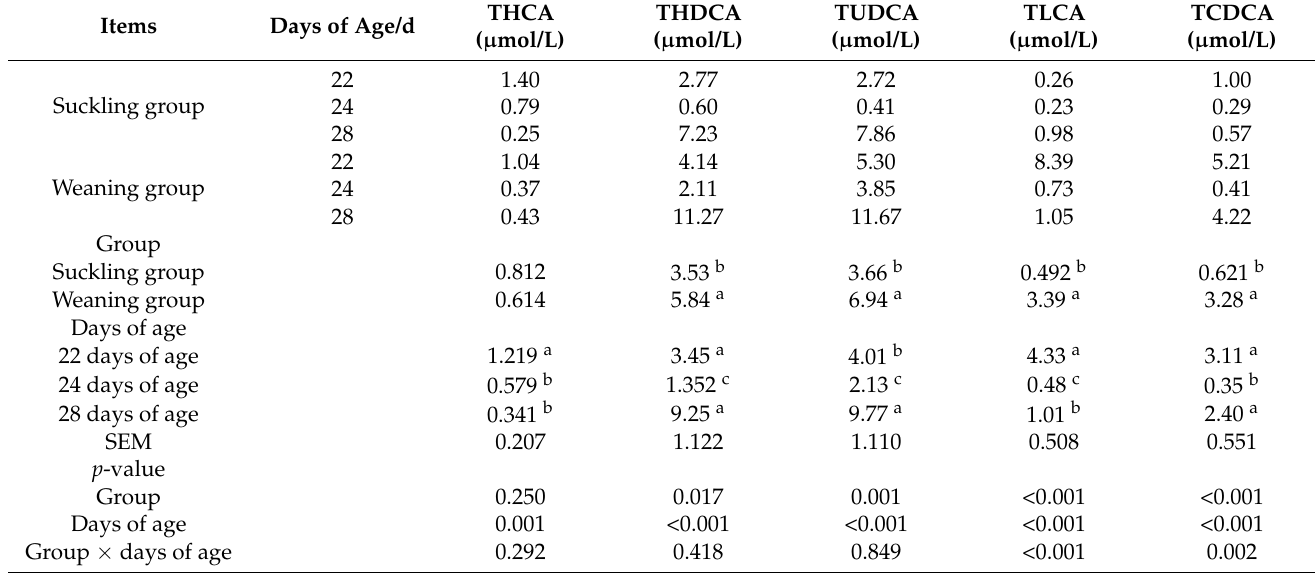
Table 5. Effects of weaning at 21 days of age on taurine-conjugated BAs of cecum